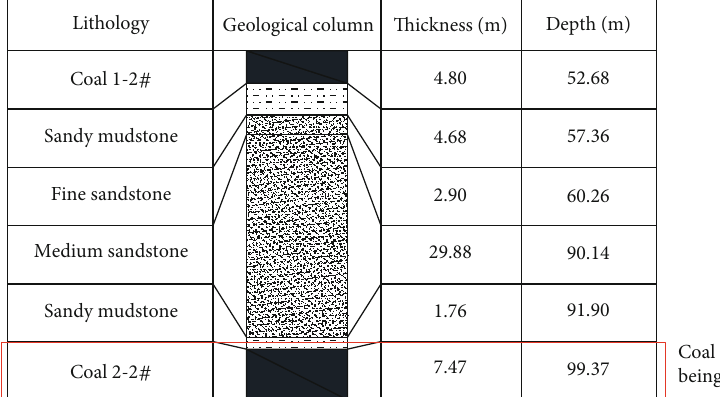
Figure 2: Geological column.